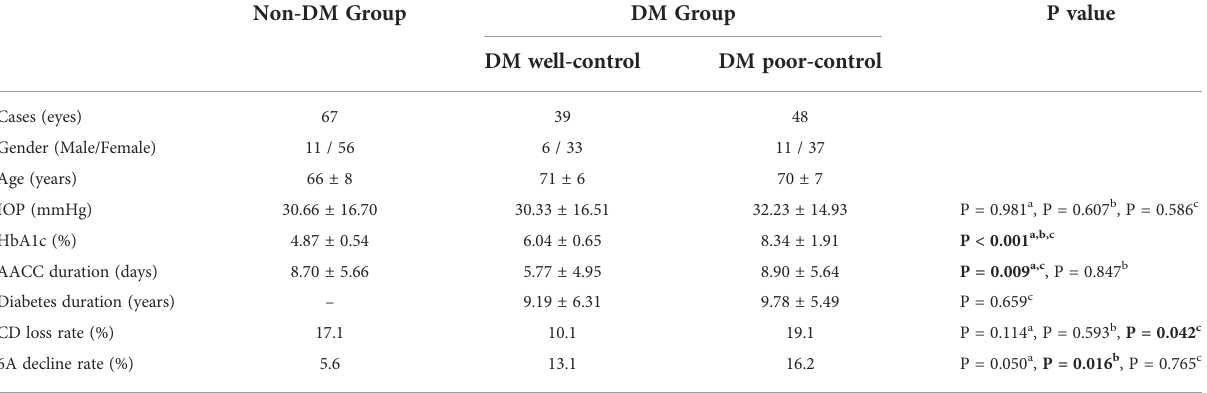
TABLE 1 Demographic and ophthalmic characteristics of the study